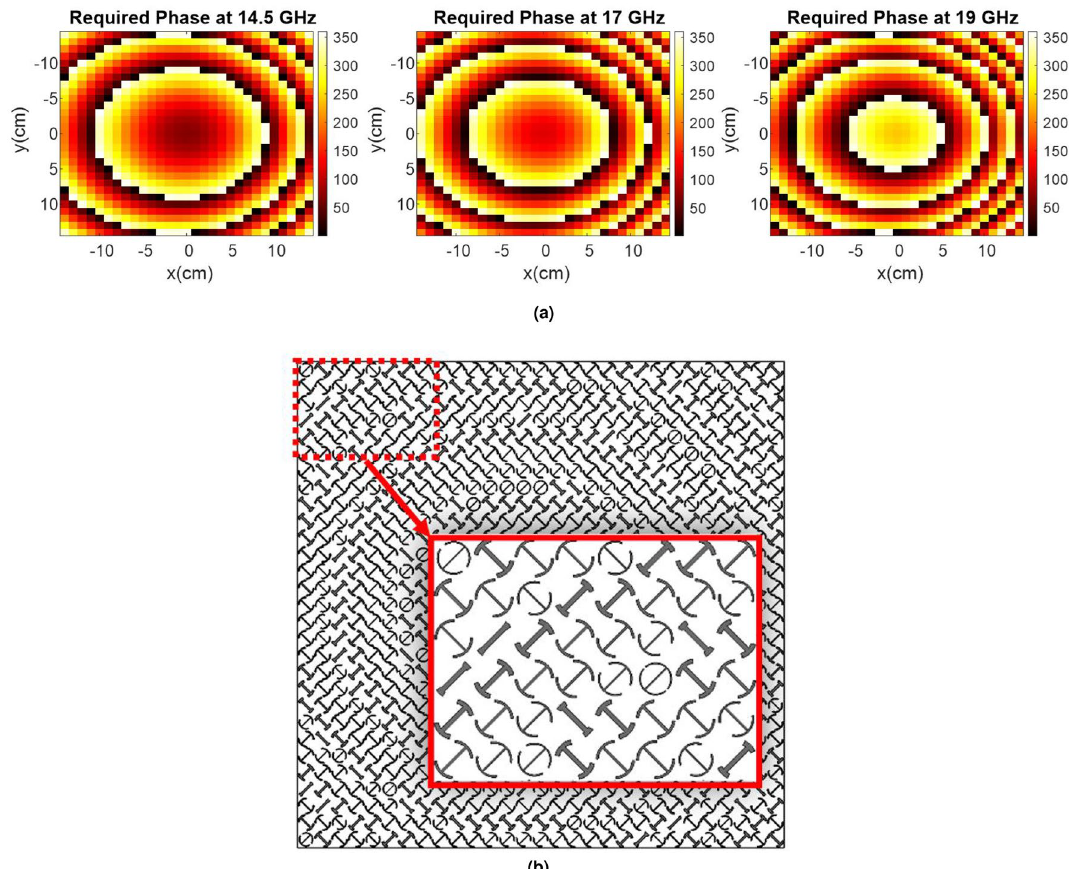
Figure 10. ( a ) Required reflection phase at three frequencies of f 1 = 14.5 GHz, f 2 = 17 GHz, and f 3 = 19 GHz. ( b ) Arrangement of the elements obtained by combining the TFPS method and